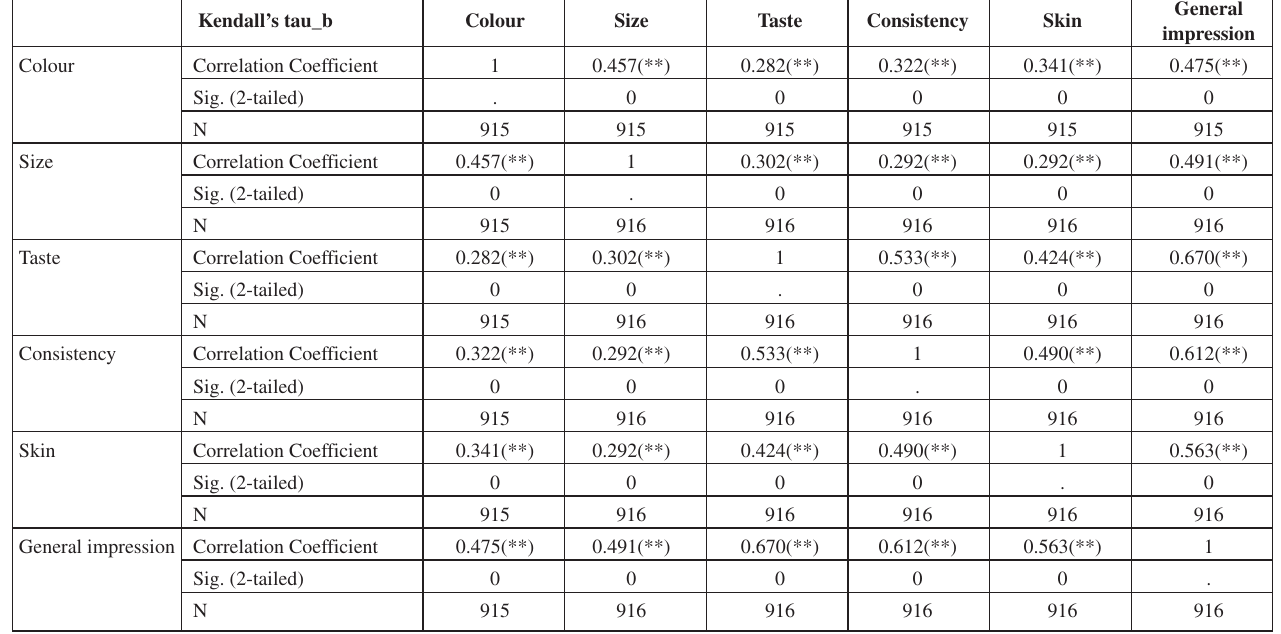
Table 1. Relation between the scores of individual characters and of general